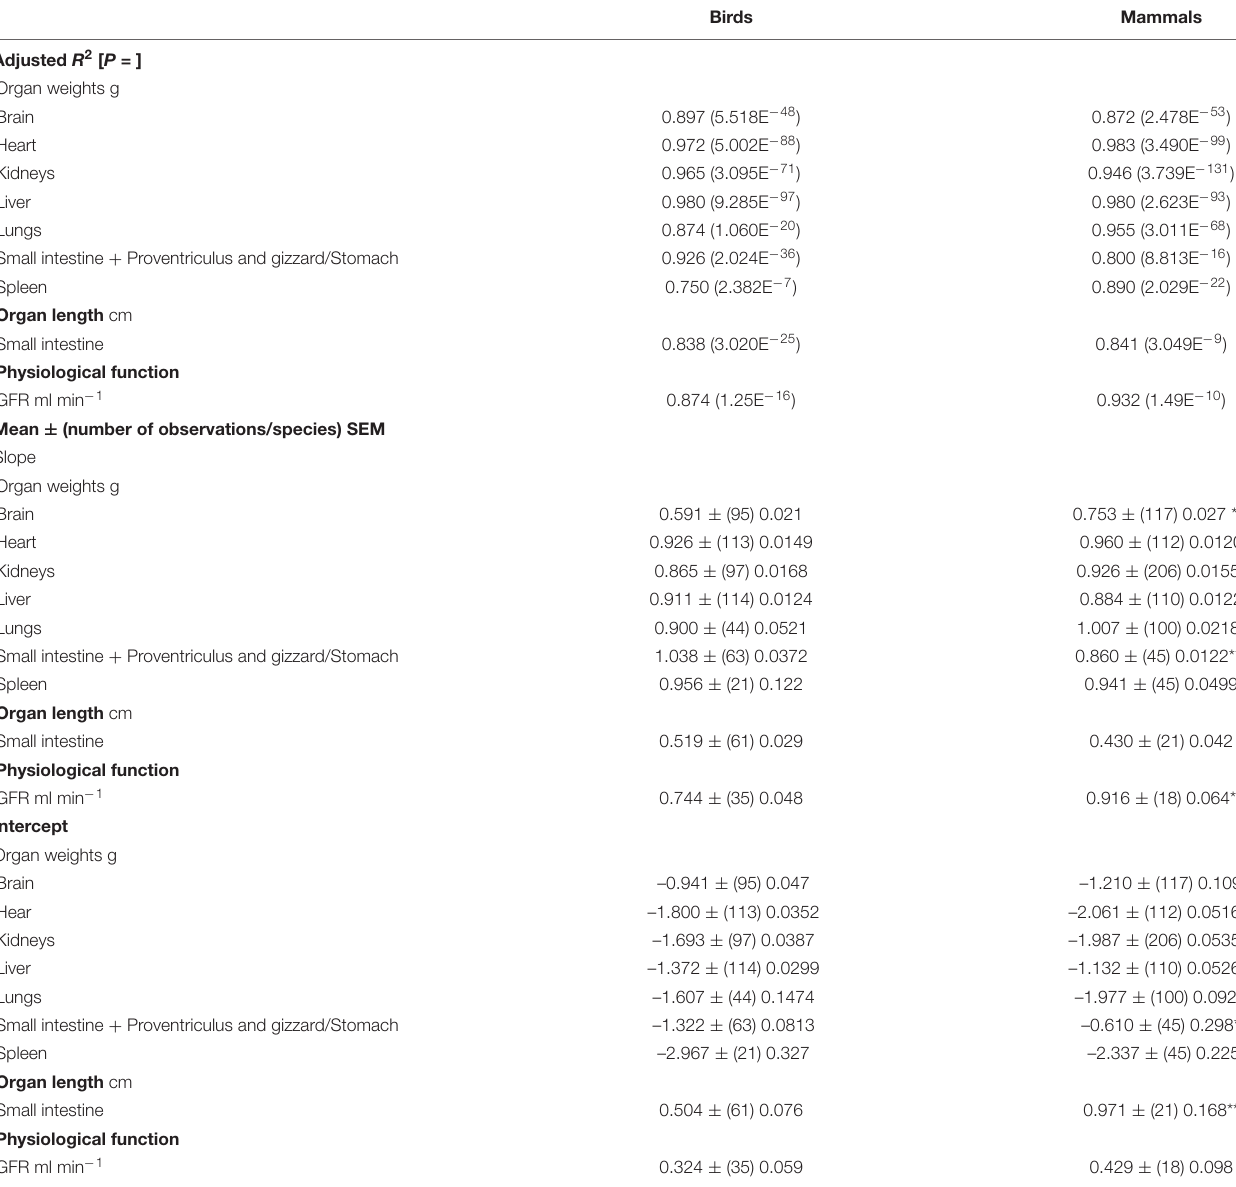
TABLE 4 | Allometric relationships between log 10 organ weight or physiological function versus log 10 body weight (g) in birds and mammals. Birds